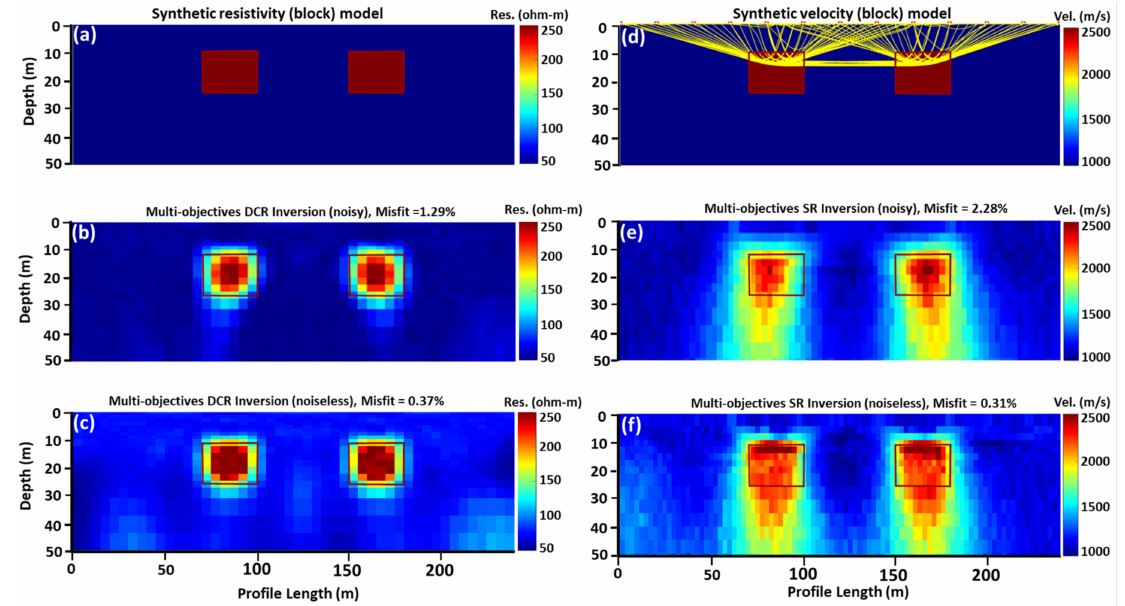
Figure 16. Test of the combined optimization algorithm using data (both DCR and SR) with added 3% gaussian noise; ( a ) synthetic dc-resistivity model, ( b ) multi-objectives inverted resistivity model (noisy), ( c ) multi-objectives inverted resistivity model (noiseless), ( d ) synthetic velocity model, ( e ) multi-objectives inverted velocity model (noisy), and ( f ) multi-objectives inverted velocity model (noiseless). The dark red lines are used to mark the anomaly